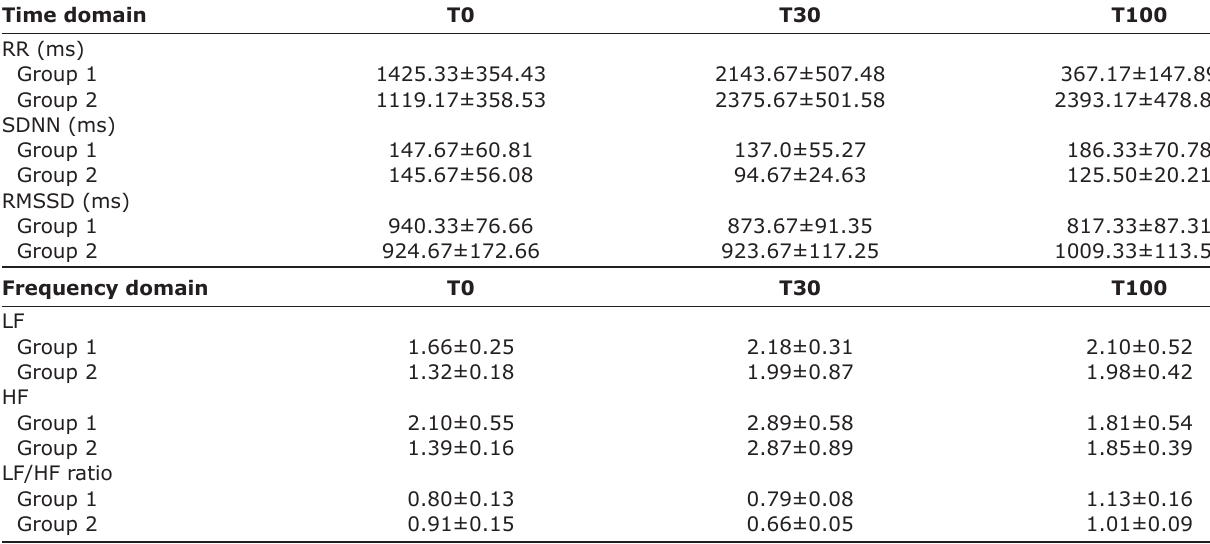
Table-1: Heart rate variability at T0, T30, and T100. Time